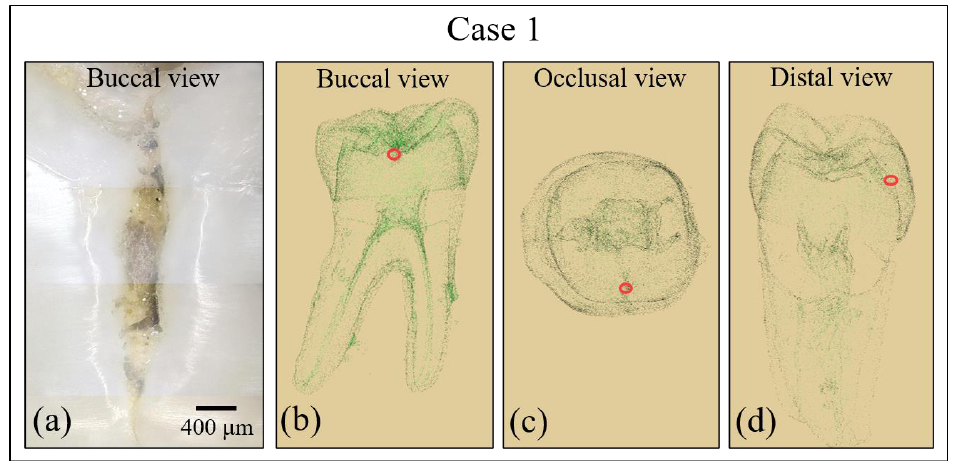
Figure 2. ( a ) Digital microscopic image of the crack damage in the tooth sample in Case 1. Image is at 100× magnification. ( b – d ) The location of the cavity and fracture in a 3D reconstructed micro-CT image in buccal ( b ), occlusal ( c ), and distal ( d ) views.